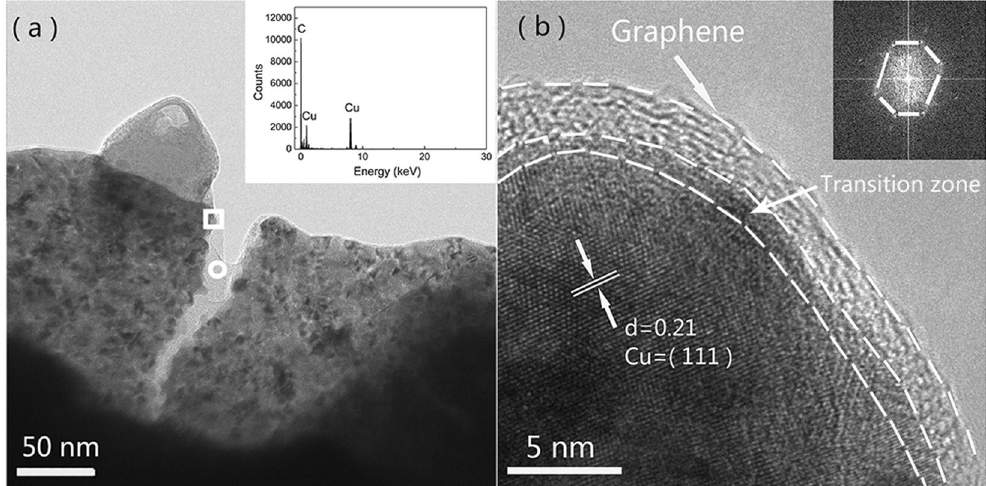
Figure 8. ( a ) Low magnification TEM image of the RGO/Cu composites and corresponding EDS analysis (inset of Fig. 2d) for the element distribution at marked circle region. ( b ) High magnification image taken from the image of marked rectangular area of Fig. 8b, the inset (FFT pattern) showed that RGO has several crystal